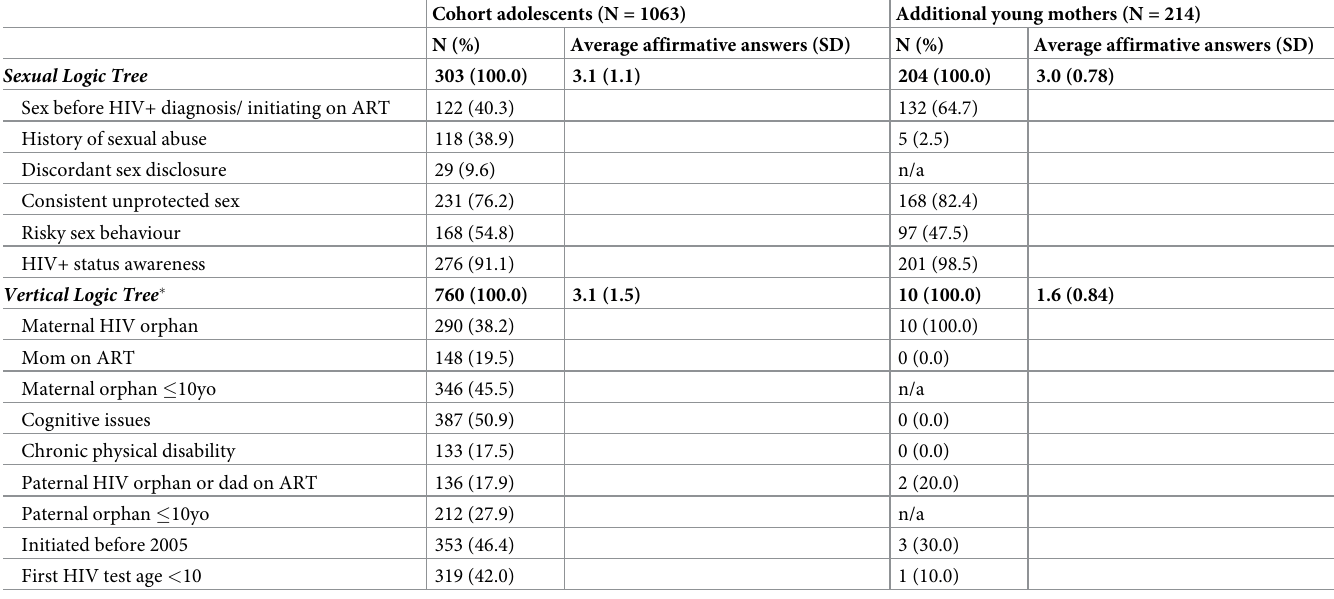
Table 4. Average number of affirmative answers to each logic tree branch after adolescents are filtered into the vertical or sexual logic